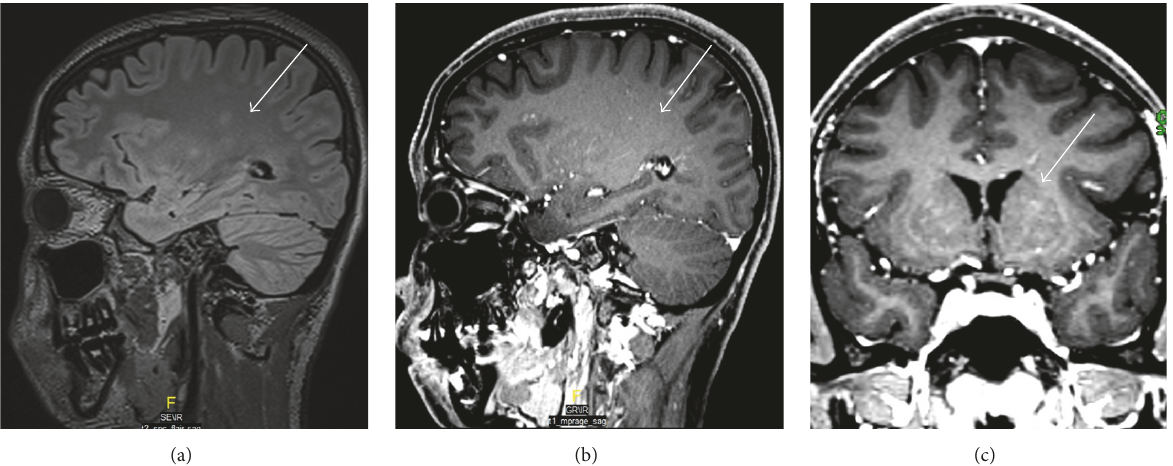
Figure 2: (a) Sagittal T2/FLAIR, (b) sagittal, and (c) coronal T1 weighted MRI after IV gadolinium based contrast medium injection, of the brain, showing white matter ill-defined faint bright intensity (arrows in (a)) and characteristic punctate and linear enhancement in white matter and basal ganglia (arrows in (b) and (c)),